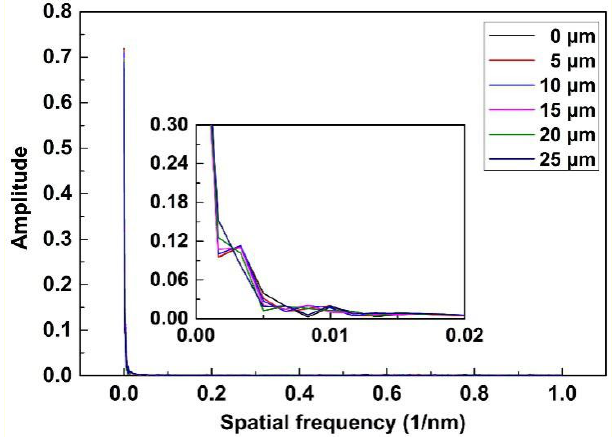
Figure 9. Fast Fourier transform (FFT) results of the original and unsmoothed SPR transmitted spectra.